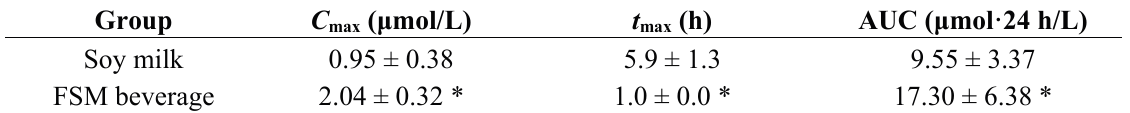
Table 1. Maximum concentration of serum isoflavones, time taken for the maximum concentration to be reached, and area under the curve for serum isoflavones in healthy adults after the ingestion of soy milk or fermented soy milk beverage [23]. Group C ( μ mol/L) t (h) AUC ( μ mol·24 h/L) max max Soy milk 0.95 ± 0.38 5.9 ± 1.3 9.55 ± 3.37 FSM beverage 2.04 ± 0.32 * 1.0 ± 0.0 * 17.30 ± 6.38 *